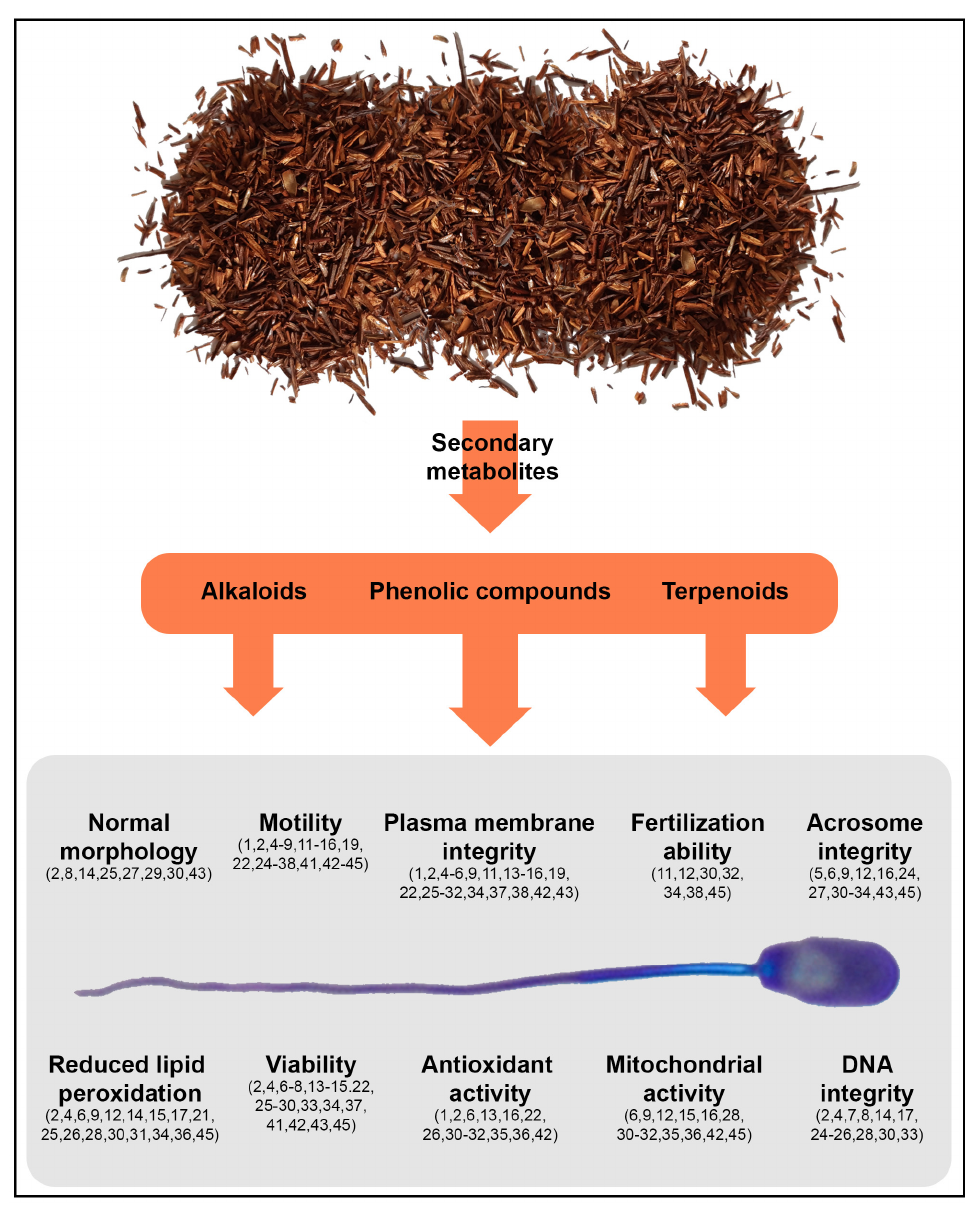
Figure 2. Positive effects of plant extracts on sperm parameters. The numbers within parentheses refer to the following plant species: Achillea millefolium (1), Albizia harveyi (2 ), Aloe vera (3), Argania spinosa (4), Aspalathus linearis (5), Camellia sinensis (6), Capparis spinosa (7), Ceratonia siliqua (8), Cyclopia intermedia (9), Cymbopogon citratus (10), Diospyros kaki (11), Echinacea purpurea (12), Entada abyssinica (13), Eurycoma longifolia (14), Foeniculum vulgare (15), Gynostemma pentaphyllum (16), Ilex paraguariensis (17), Lippia origanoides (18), Lolium perenne (19), Melaleuca alternifolia (20), Melissa officinalis (21), Moringa oleifera (22), Myrrhinium atropurpureum (23), Nigella sativa (24), Opuntia ficus-indica (25), Origanum vulgare (26), Phoenix dactylifera (27), Portulaca oleracea (28), Psidium guajava (29), Punica granatum (30), Rhodiola rosea (31 ), Salvia miltiorrhiza (32 ), Salvia officinalis (33), Salvia rosmarinus (34), Sambucus nigra (35), Schisandra chinensis (36), Syzygium aromaticum (37), Syzygium cumini (38), Thymus capitatus (39), Thymus munbyanus (40), Tribulus terrestris (41), Ugni molinae (42), Urtica dioica (43), Viscum album (44), Zingiber officinale (45).